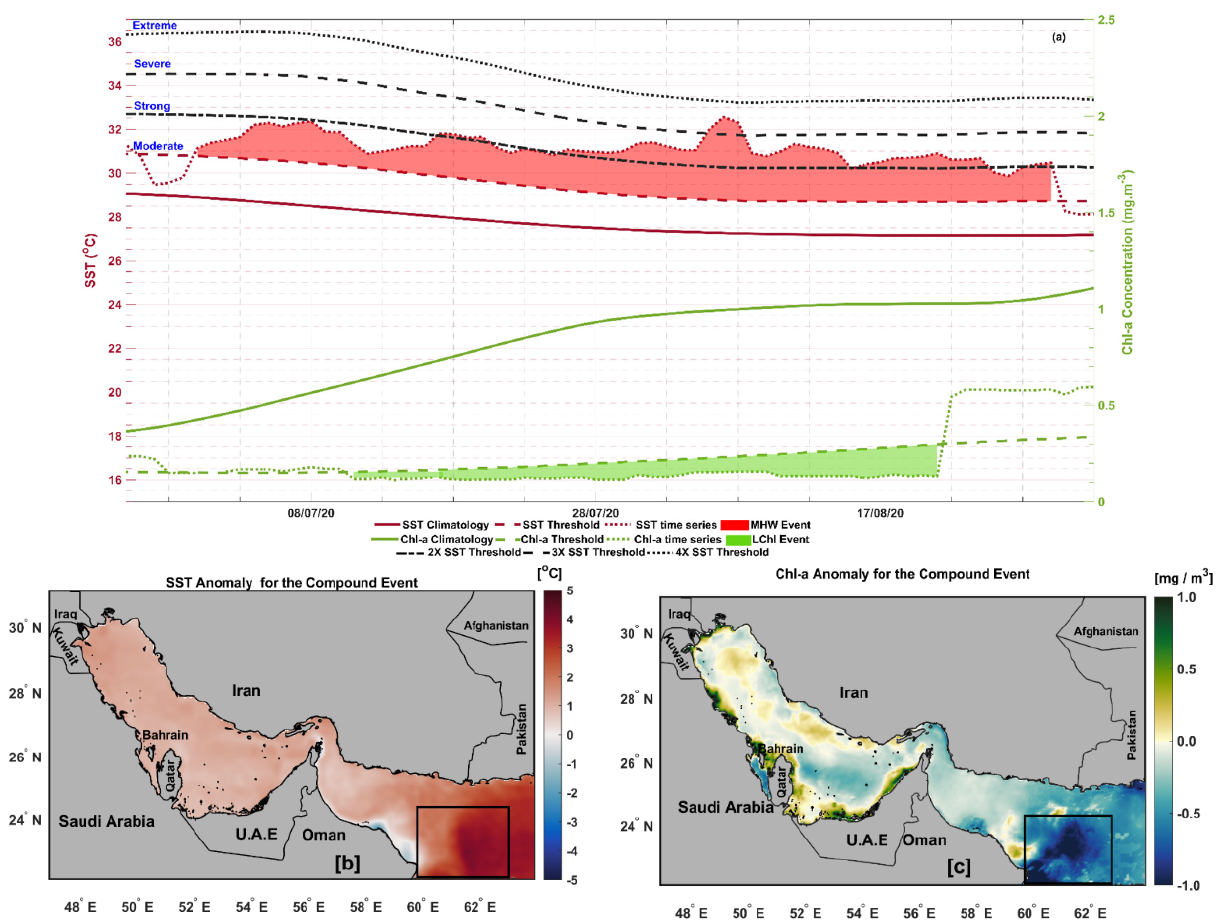
Figure 10. ( a ) The longest compound MHW and LChl-a event. The red shaded area refers to the MHW event, while the green one represents the LChl-a event. The black dotted line defines the MHW categories (moderate, strong, severe, and extreme), ( b ) the SSTA (°C), and ( c ) the Chl-a anomaly (mg/m 3 ) averaged during the compound event (10 July to 21 August 2020). Note that the anomalies are calculated with respect to the period [1998–2020]. The black rectangle in b and c defines the area that was affected by the compound event.